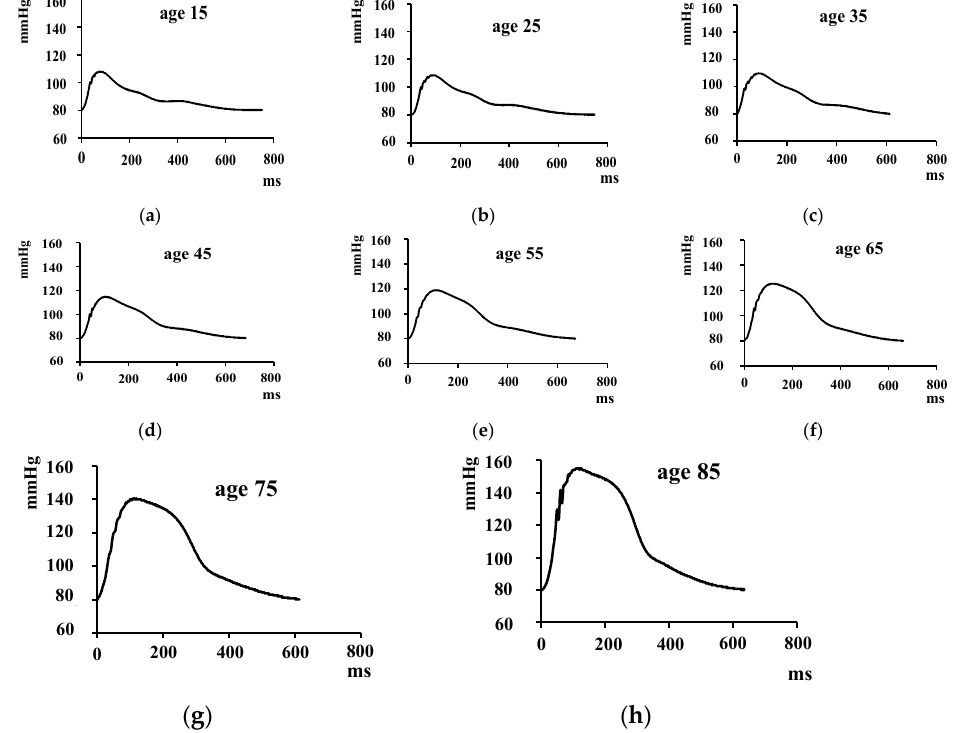
Figure 4. Age-specific blood pressure waveforms artificially generated in a 3D cam-based age-specific pulse pressure simulator: ( a ) a pulse pressure waveform graph of 15 years old; ( b ) 25 years old, ( c ) 35 years old; ( d ) 45 years old; ( e ) 55 years old, ( f ) 65 years old; ( g ) 75 years old; ( h ) 85 years old. To further evaluate the (artificial) pulse pressure waveforms (produced by 3D CAM),